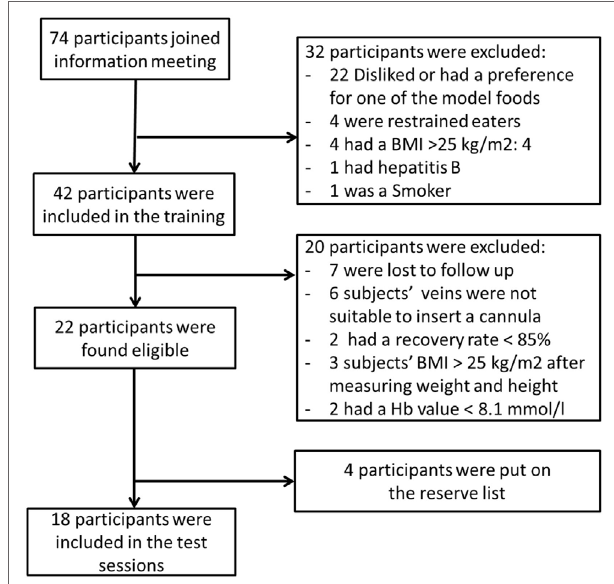
FigUre 1 | Flow chart of the in- and exclusion of